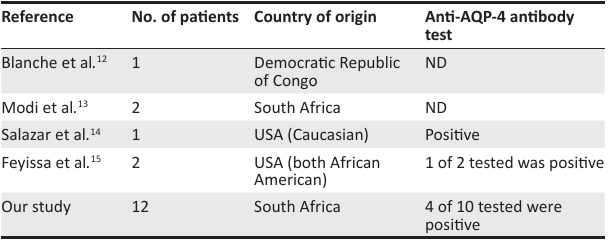
TABLE 4: Literature survey of neuromyelitic presentation in HIV-seropositive patients.